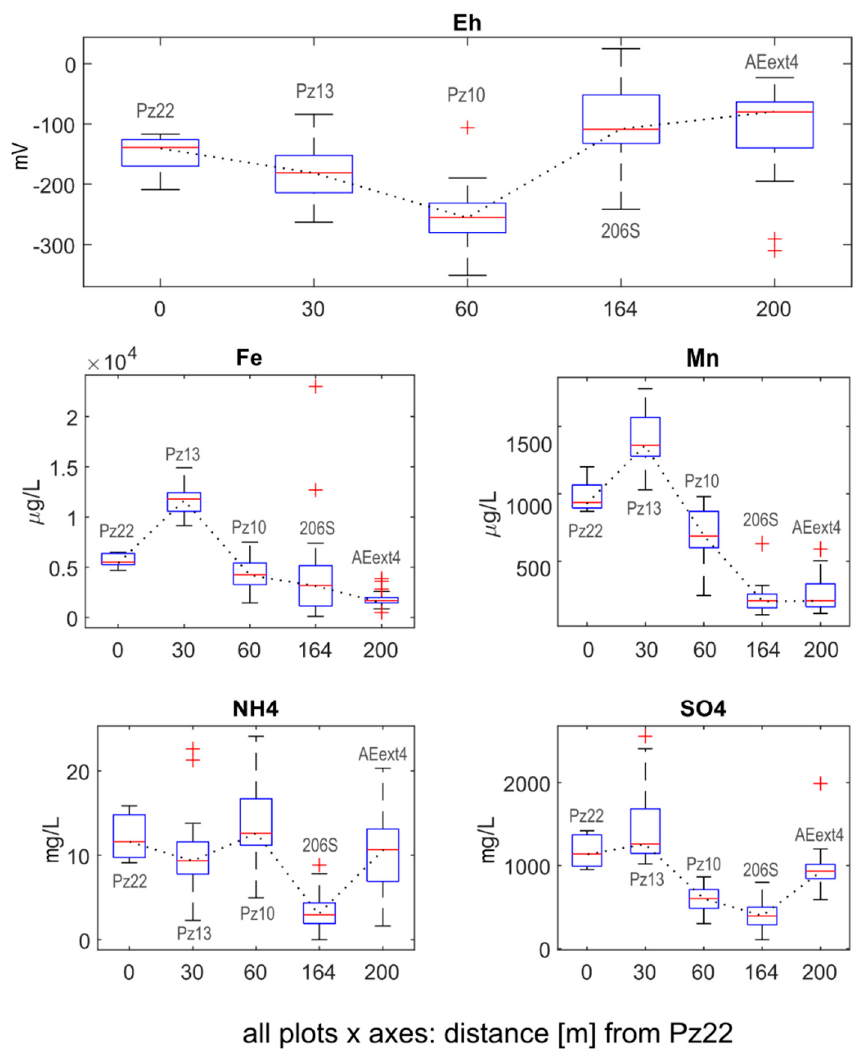
Figure 3. Evolution of the oxidizing–reduction potential (expressed as Eh), iron, manganese, ammonium and sulfate concentrations along the transect from Pz22 to AEext4 for all available sampling campaigns. The dotted black line connects the median values (red marks) of the different